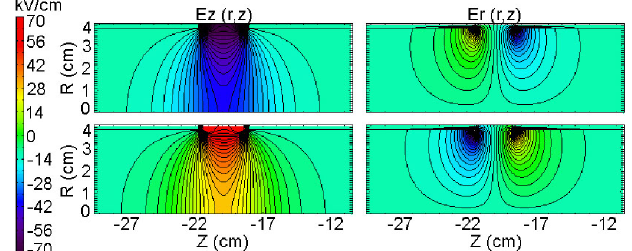
(cid:2) r; z (cid:3) at t (cid:4) 200 ns z (cid:2) r; z (cid:3) at t (cid:4) 200 ns r